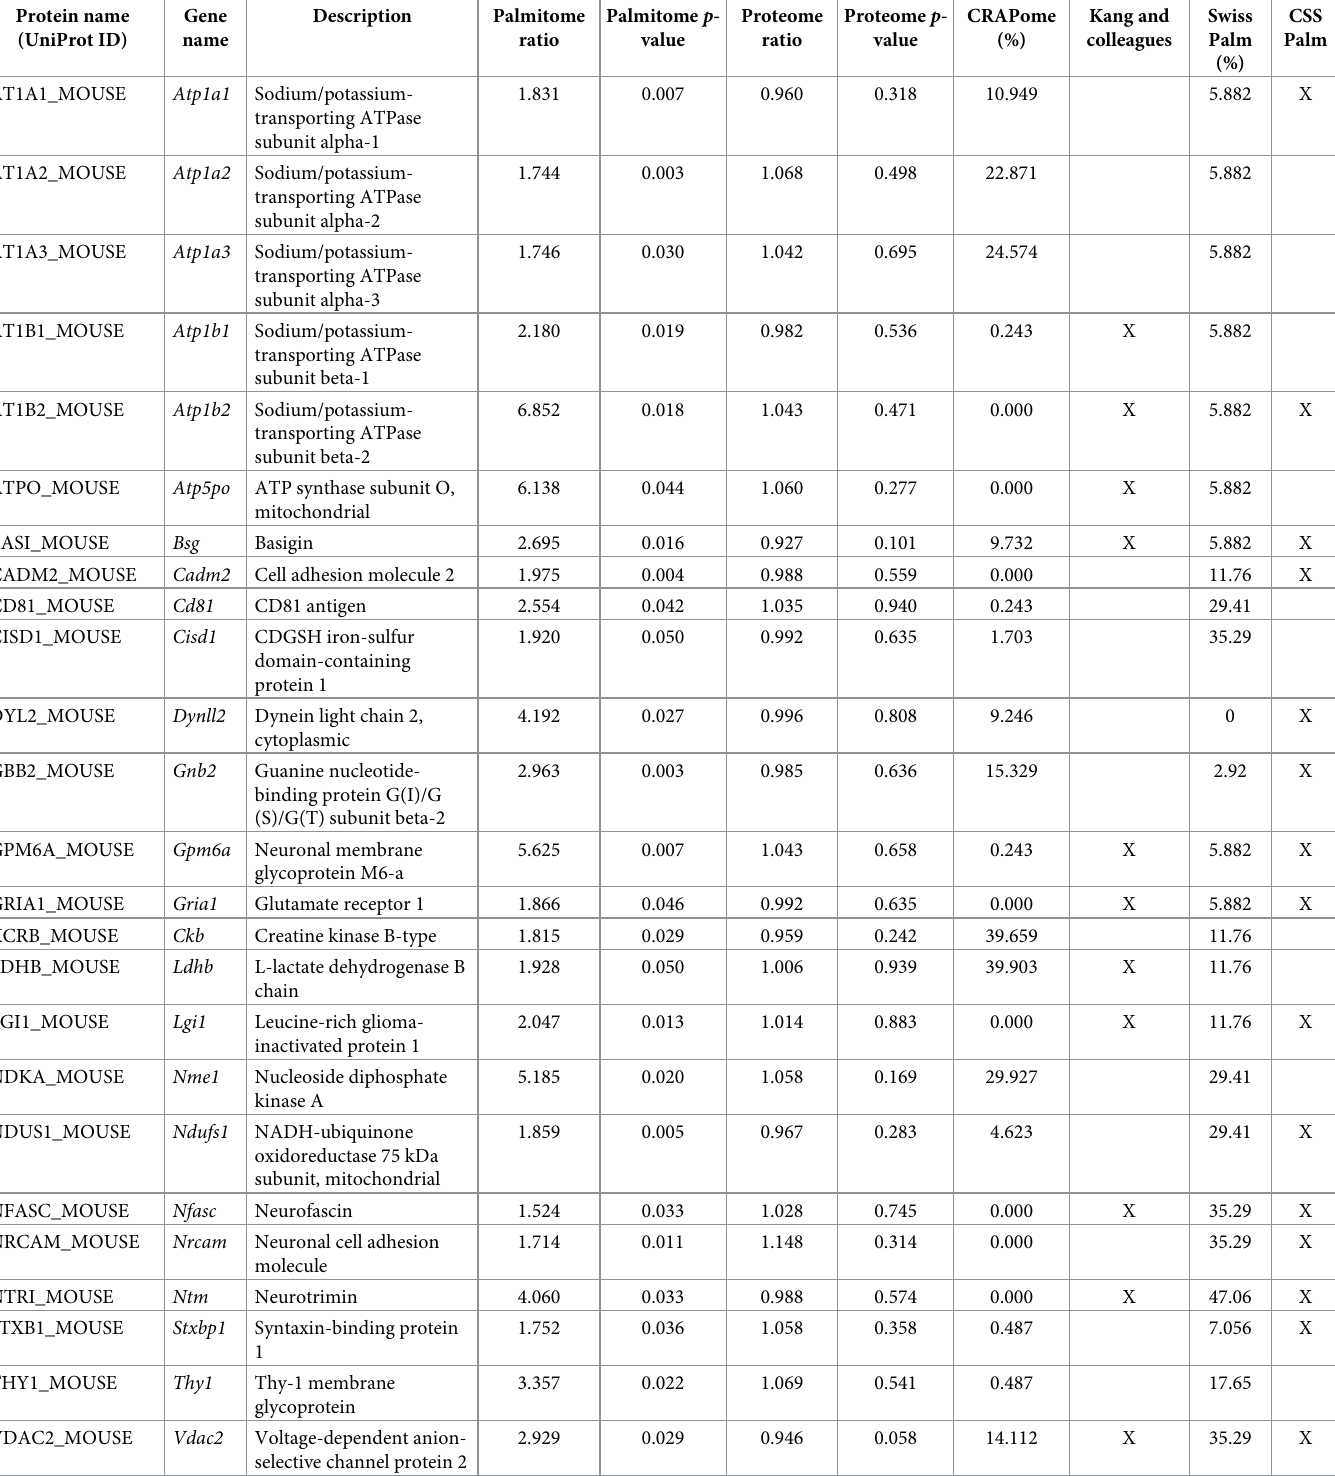
Table 1. High-confidence validated PPT1